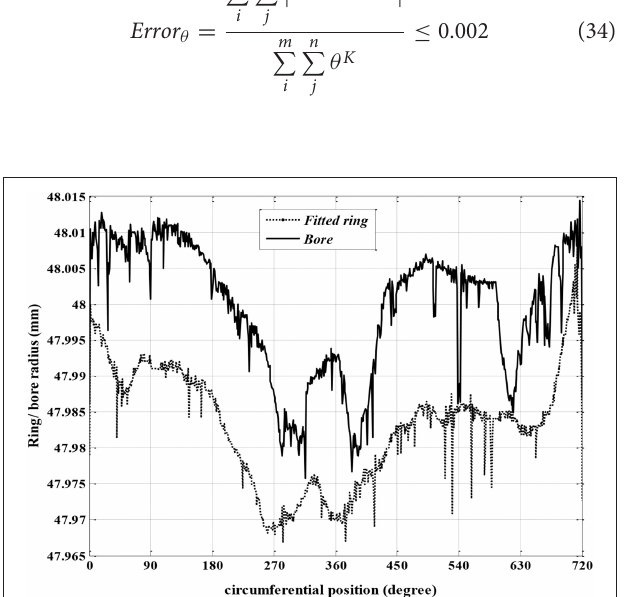
FIGURE 6 | Freely conforming ring-bore.